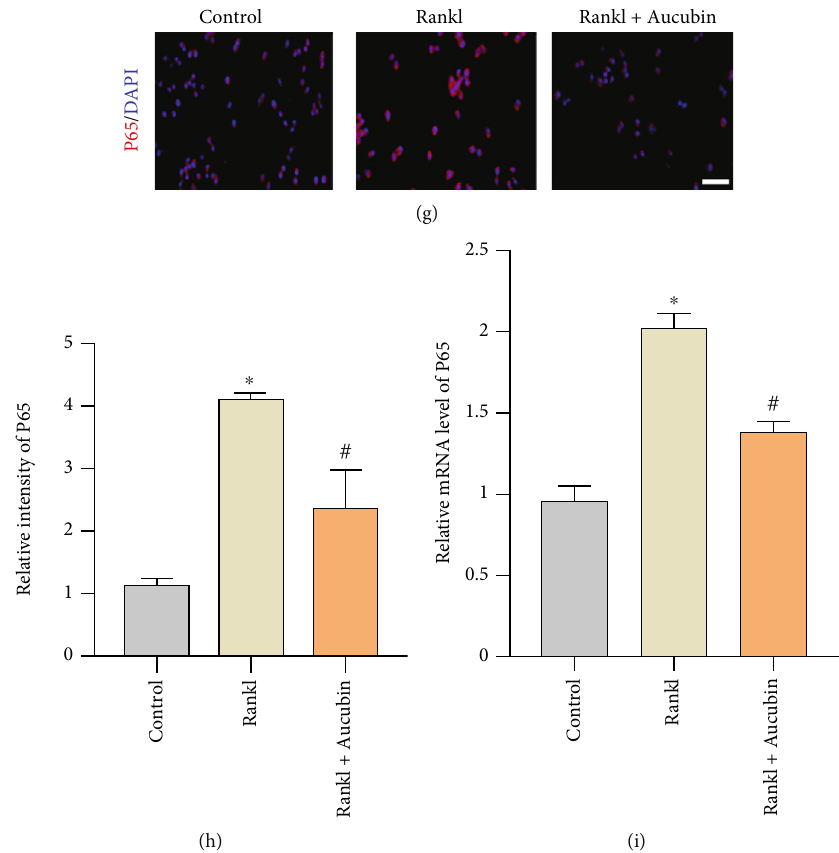
Figure 6: Aucubin inhibits the MAPK and NF- κ B signaling pathways. (a) Protein levels of the MAPK family were analyzed by WBs. (b – d) Quanti fi cation of MAPK family protein expression. ∗ P < 0 : 05 compared to the Rankl group at 20 min; # P < 0 : 05 compared to the Rankl group at 30min. (e) Protein levels of the NF- κ B family were analyzed by WBs. (f) Quanti fi cation of NF- κ B family protein level. ∗ P < 0 : 05 compared to the Rankl group at 20min; # P < 0 : 05 compared to the Rankl group at 30min. (g) Location of p65 fl uorescence was observed via IF. Scale bar: 50 μ m. (h) Relative p65 fl uorescence intensity was analyzed. ∗ P < 0 : 05 compared to the control group; # P < 0 : 05 compared to the Rankl group. (i) Relative p65 mRNA was analyzed. ∗ P < 0 : 05 compared to the control group; # P < 0 : 05 compared to the Rankl